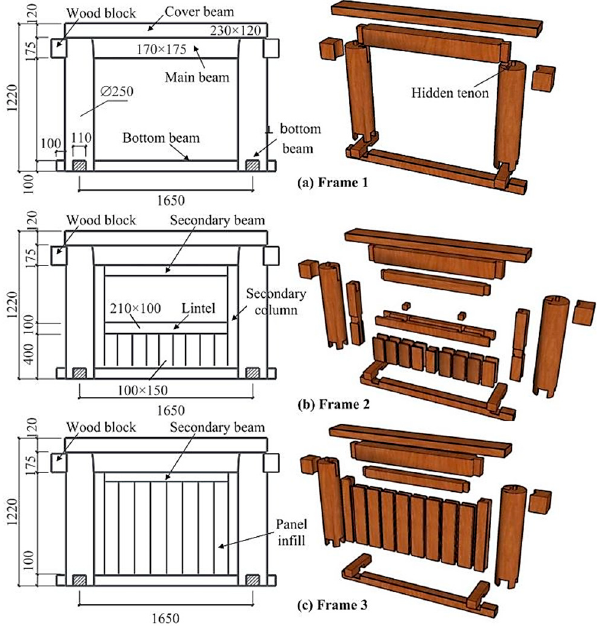
Figure 13. Layout of frames tested in [90].